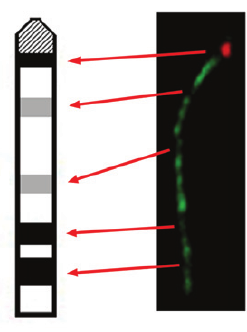
Fig. 6. Late pachytene. Comparison of the distributions of gaps in the SC for the second biggest bivalent and G- band for the second biggest mitotic chromosomes (Romanenko et al.,